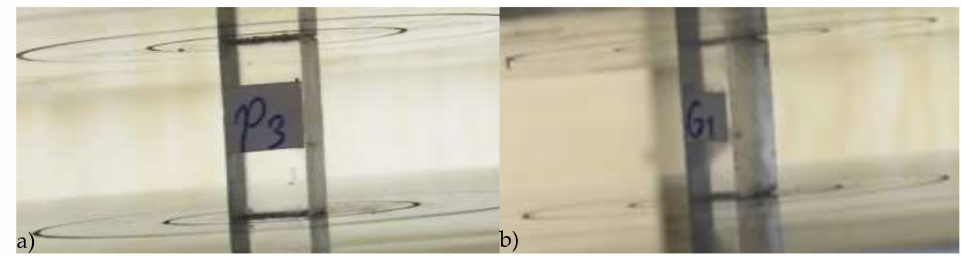
Figure 6. Examples of specimens at the onset of the compressive stress. ( a ) PMMA; ( b ) GPPS.